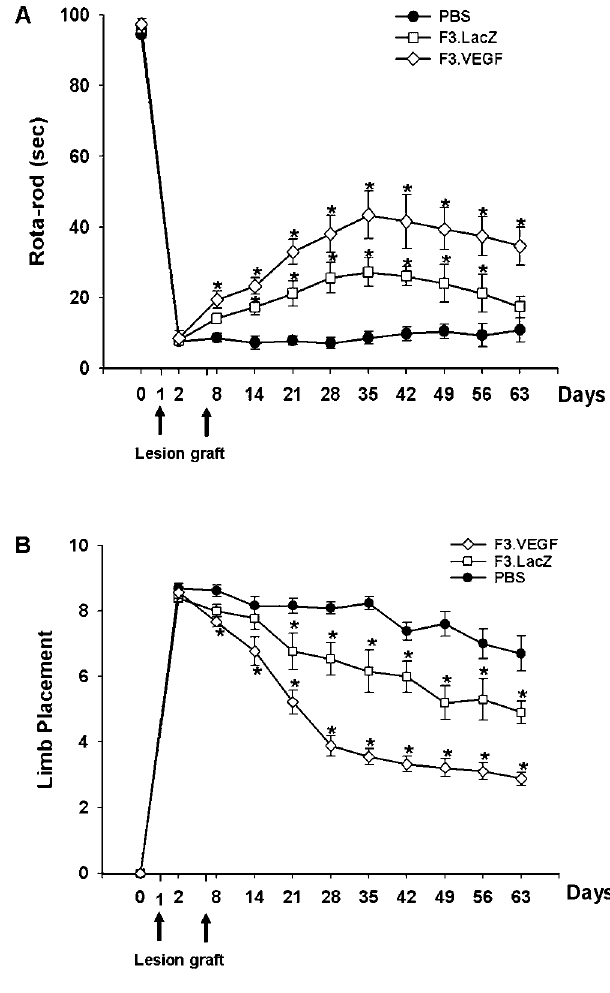
Figure 4. Behavioral improvement demonstrated in mice with in- tracerebral hemorrhage (ICH) transplanted with F3 or F3.VEGF human neural stem cell lines. A: Rotarod test. F3.VEGF-transplanted group showed better performance than PBS controls or F3-transplanted group from 8 days on, and these benefits continued up to 8 weeks post- transplantation (P , 0.001). B: In the modified limb placement test, F3.VEGF-transplanted group showed better performance than PBS or F3-transplanted group (P ,